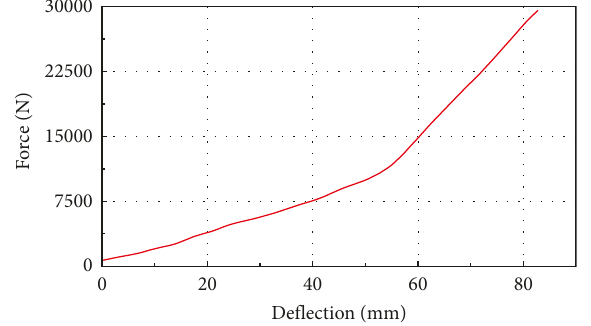
Figure 3: Stiffness curves of lug bushing.